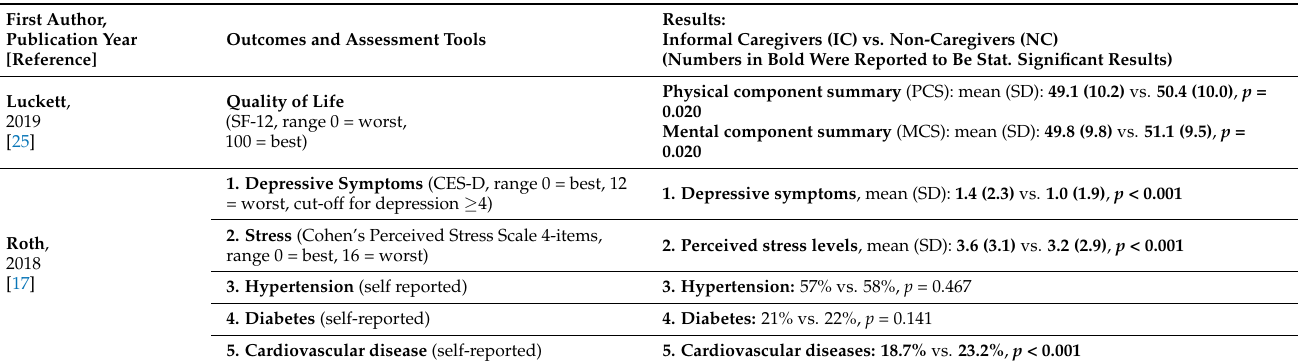
Table 4. Cross-sectional evaluations: disease burden outcomes comparing informal caregivers (IC) and non-caregivers